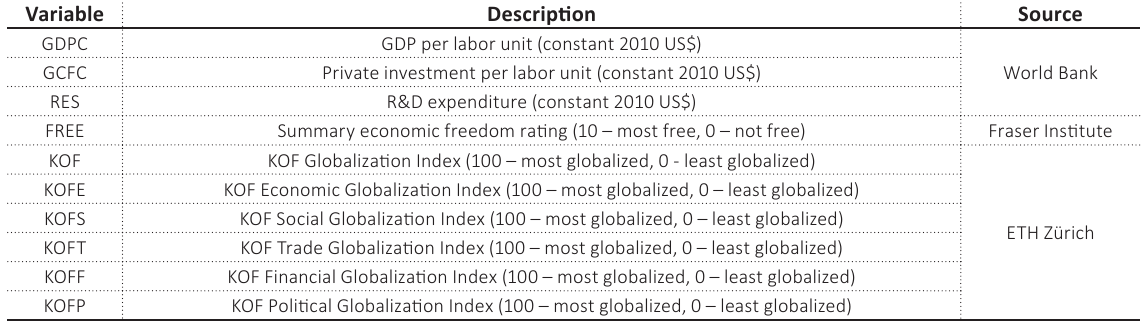
Table 1. Description of variables Variable